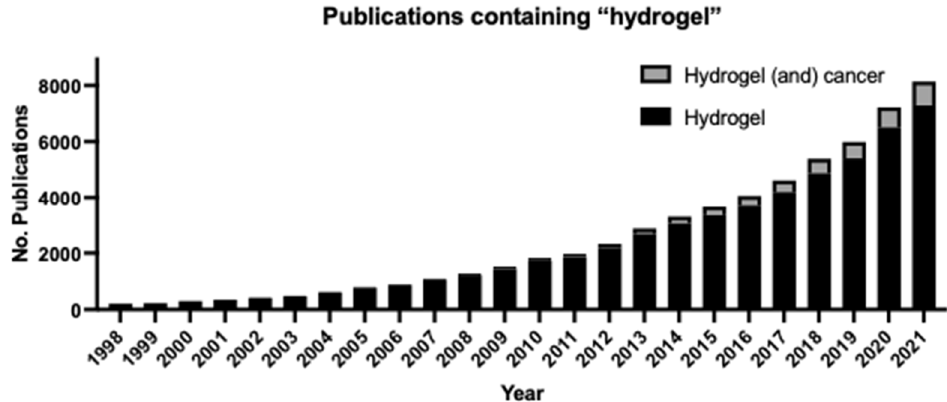
Figure 7. A bar chart showing the number of publications containing the key word “hydrogel” or (“hydrogel” AND “cancer”) from the years 1998 to 2021 found in the PubMed database. (“hydrogel” AND “cancer”) from the years 1998 to 2021 found in the PubMed